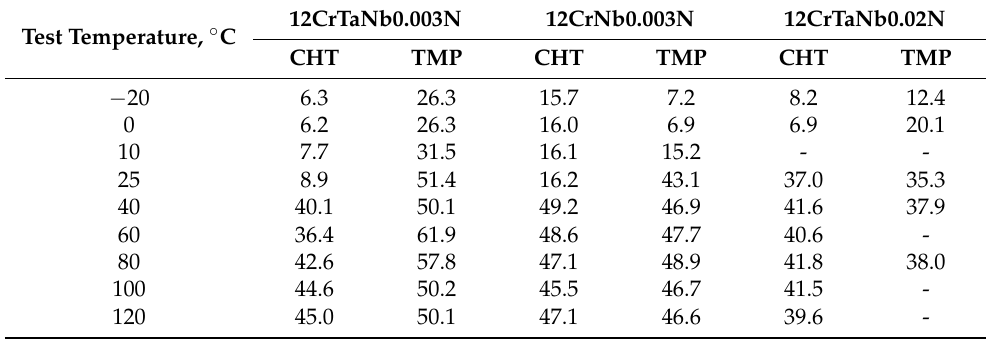
Table 2. Crack initiation energies E i (in J) for the different 12% Cr steels.